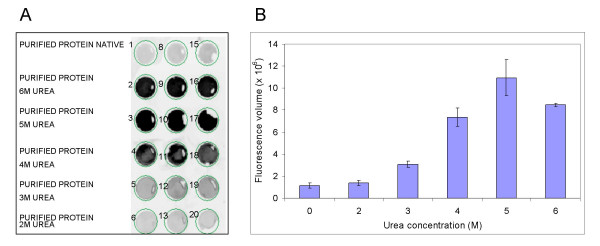
Determination of dot blot denaturation conditions to use. Purified EfnB2-EC in mock supernatant was incubated in urea at different concentrations for 1 hour at room temperature prior to loading onto a nitrocellulose membrane in triplicate using the dot blot apparatus. After detection of His tagged proteins (see Methods section) with anti-His tag mAb and Cy5 labelled goat anti-mouse antibody the blots were scanned on a Typhoon 8600 variable mode imager (A) and dots were quantitated using ImageQuant software (B).